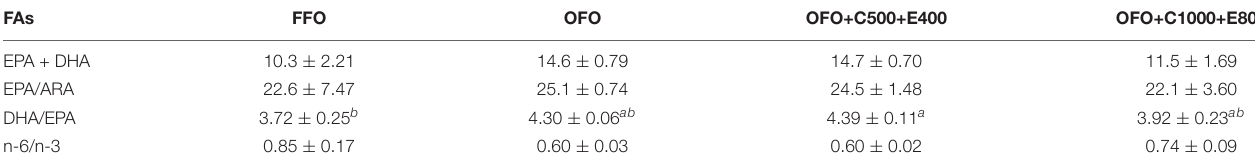
TABLE 5 | Serum biochemical parameters of rainbow trout fed the experimental diets for 10 weeks.